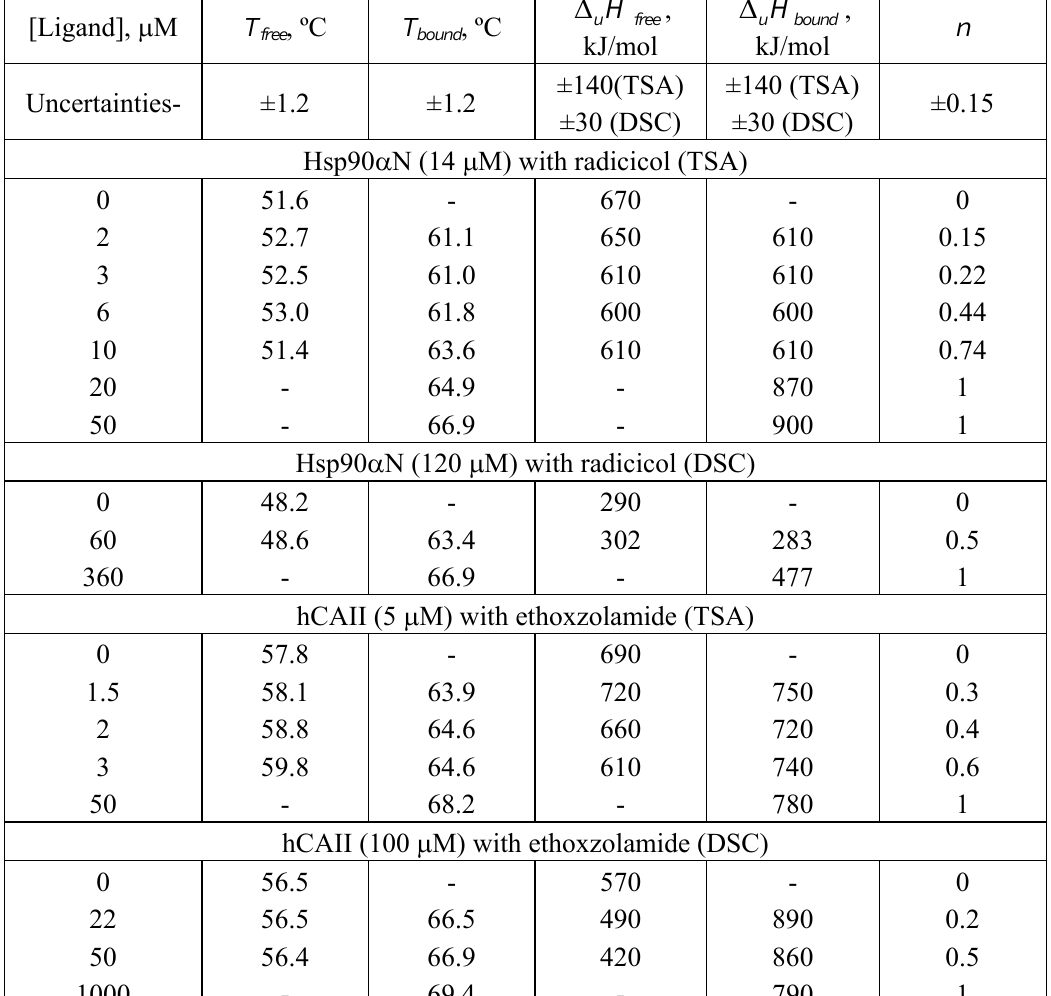
Table 1. Thermodynamic parameters of free and ligand-bound unfolding of Hsp90 α N (14 μ M) and hCAII obtained by fitting to the data in Figure